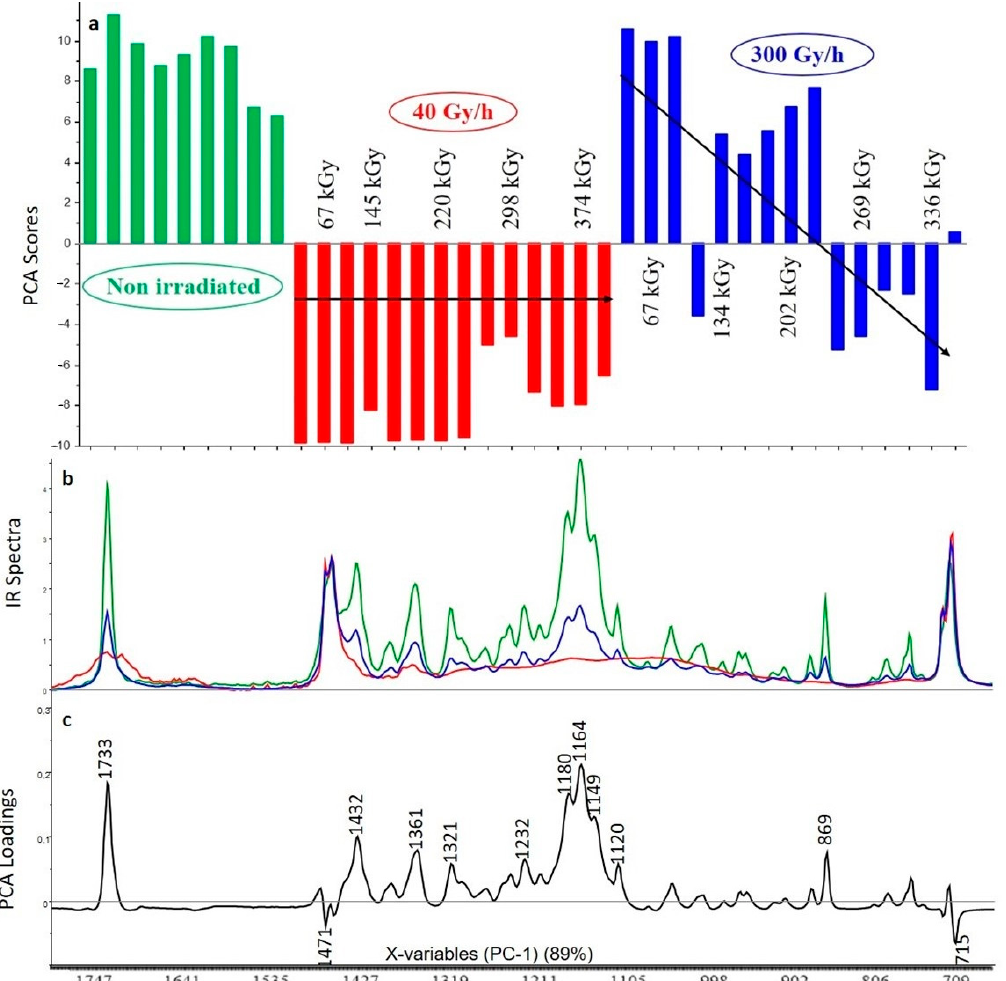
Figure 5. PCA scores ( a ), FTIR spectra for highest dose ( b ) and PCA loadings ( c ) of the first principal component (PC1) for the analysis of XLPE with Irganox 1076 (green: unaged samples, red: samples irradiated at 40 Gy/h, blue: samples irradiated at 300 Gy/h).